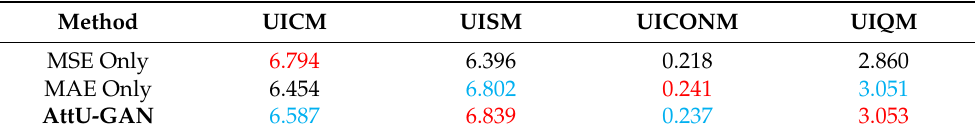
Table 6. No ‐ reference image quality evaluation (UIQM). Table 6. No-reference image quality evaluation (UIQM).